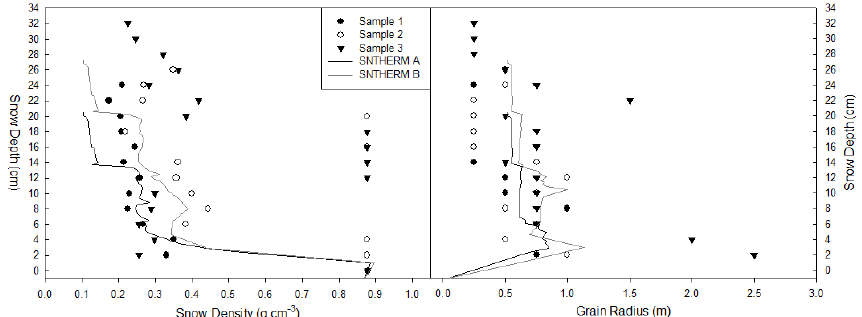
Figure 8. In situ measured and SNTHERM simulated density and grain radius values. Note the high density ice layer observed in samples 2 and 3, between 12 and 22cm snow